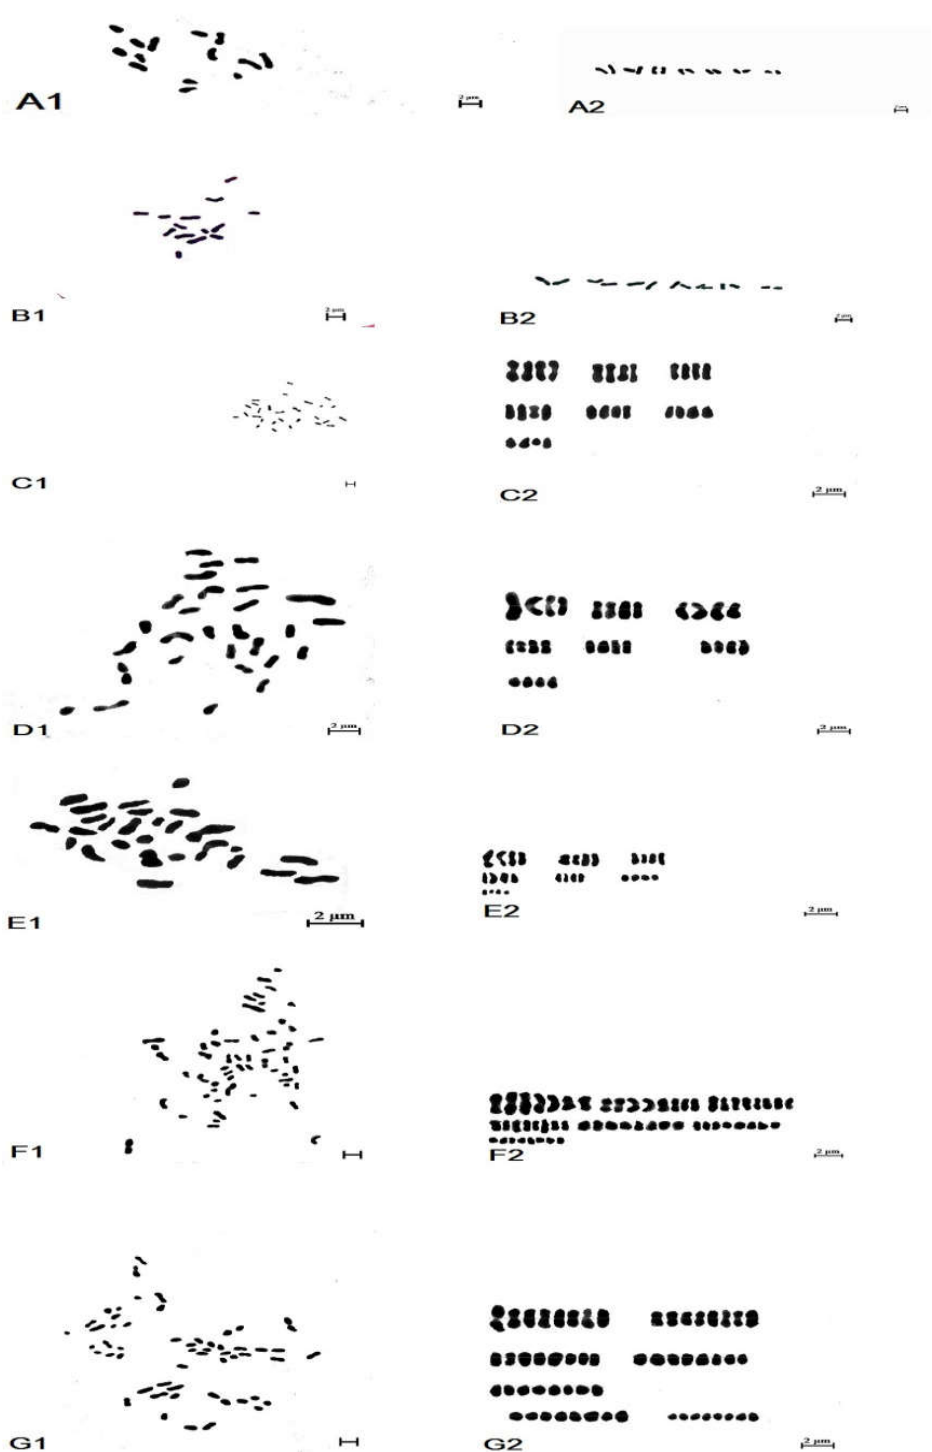
Fig. 1. Representative metaphase somatic cells and karyogrms in the studied species of Rubus (Rosaceae): A- B) Joybar and Babolsar populations of R. sanctus , showing 2n =2x=14, respectively; C -D) Nur and Hashtpar populations of R. caesius showing 2n =4x= 28, E) Heyran pass of R. discolor showing 2n=4x=28; F-G) Loveh and Saravan populations of R. persicus , showing 2n =8x=56 respectively. Scale bar =